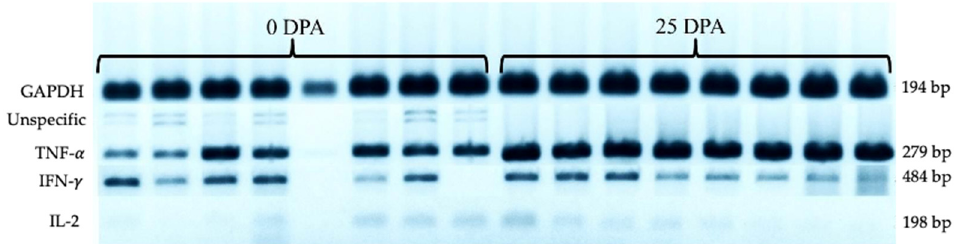
Figure 2. Agarose gel (1.5%) for TNF- α , IFN- γ , IL-2, and GAPDH. The first 8 columns correspond to the 0 DPA group, and the last 8 columns correspond to the 25 DPA group. Non-specific amplifications were only observed in the 0 DPA animals. The arrowhead indicates non-specific bands for TNF- α .